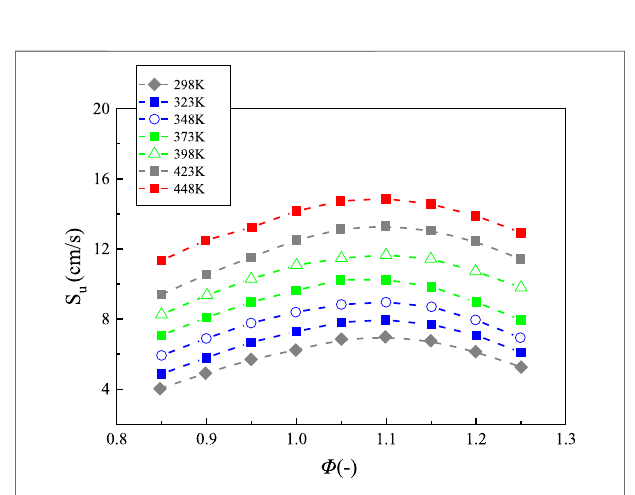
FIGURE 5 | Laminar burning velocity of NH 3 fl ame with a function of equivalence ratio at various temperature, replotted from (Han et al., 2020).